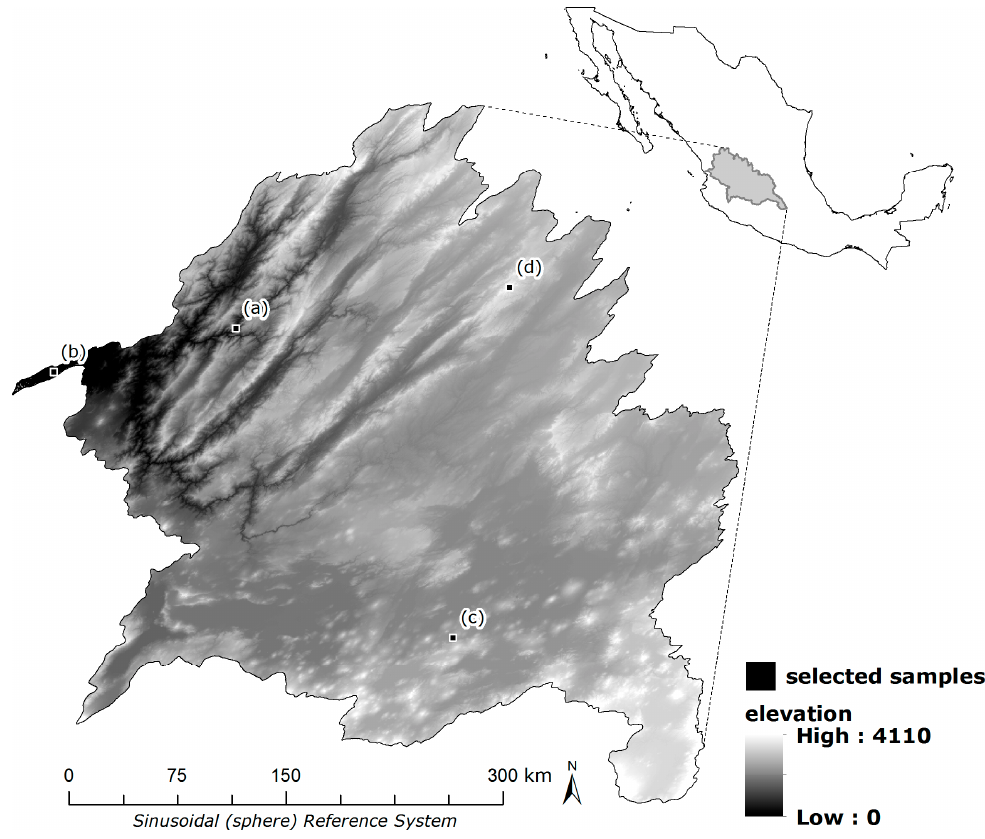
Figure 1. Location and Elevation of Lerma-Chapala-Santiago Watershed and four selected sample regions ( a – d ), with location in country of Mexico.